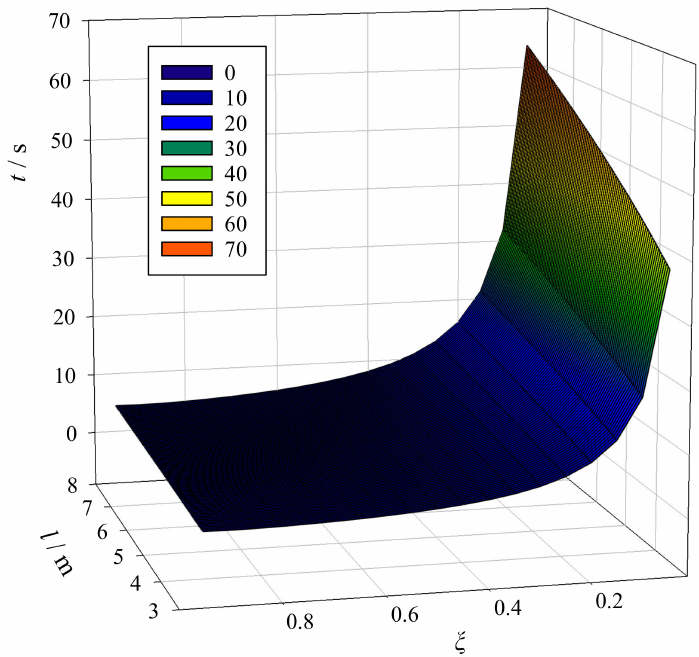
Figure 9. Influence of the damping coefficient and the rope length on the attenuation